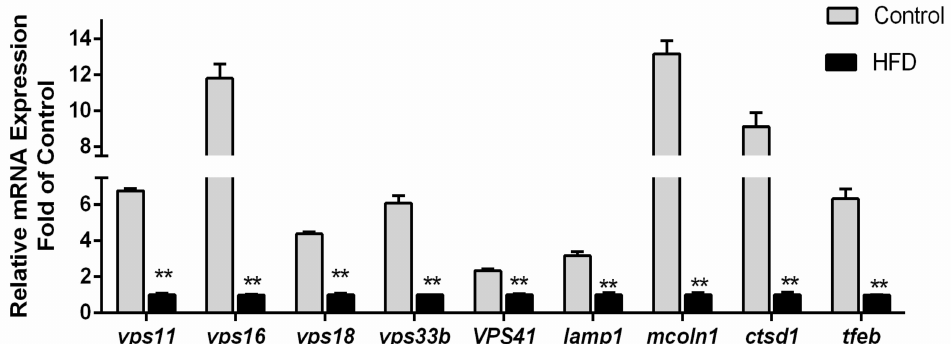
Figure 2. E ff ect of dietary fat levels on hepatic mRNA level of autolysosomes-related genes in P. fulvidraco . a,b,c Values are mean ± standard error of the mean (SEM), n = 3 (replicates of 3 fish); Asterisks indicate significant di ff erences between two groups within the same gene ( p < 0.05). CD = Control diet: HFD = High-fat